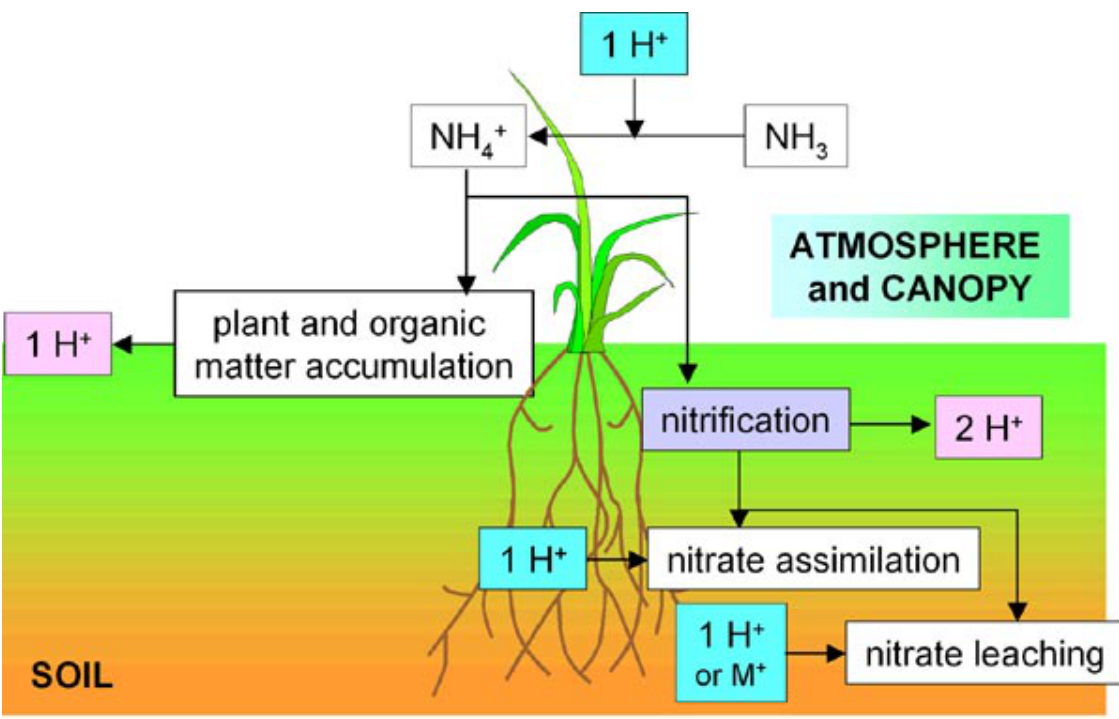
FIGURE 2. Fate of NH 3 and NH 4+ in plant and soil systems in relation to potential soil acidification (after